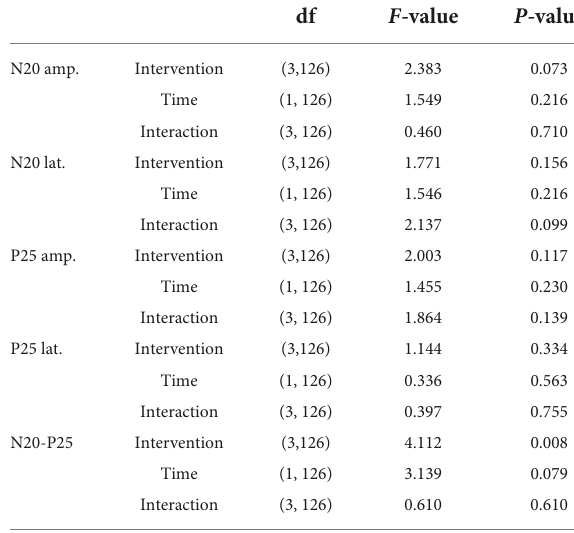
TABLE 1 Statistical results of single-pulse SEP